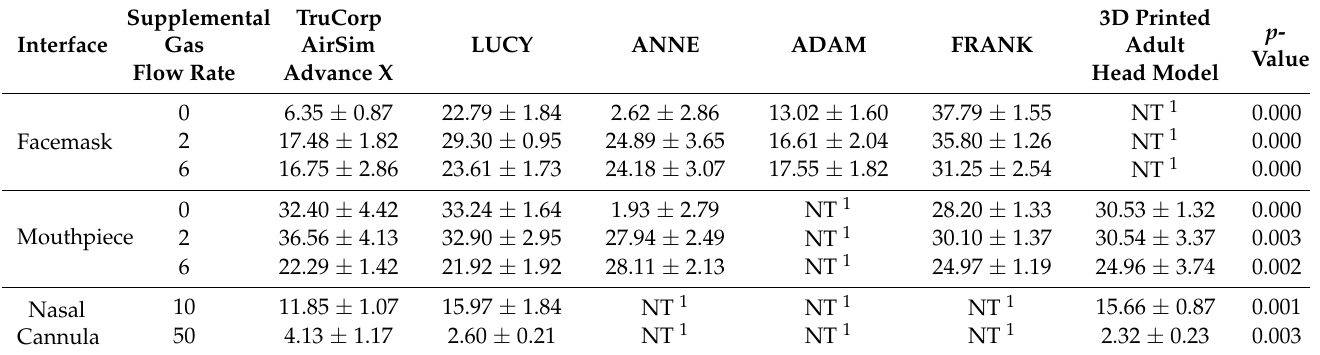
Table 2. Mean ± SD % tracheal dose for Adult head models in combination with the Aerogen Ultra with a facemask or mouthpiece and the Aerogen Solo/Airvo 2 with Optiflow Nasal cannula at supplemental flow rates of 0, 2 and 6 LPM and high flow gas rates of 10 and 50 LPM